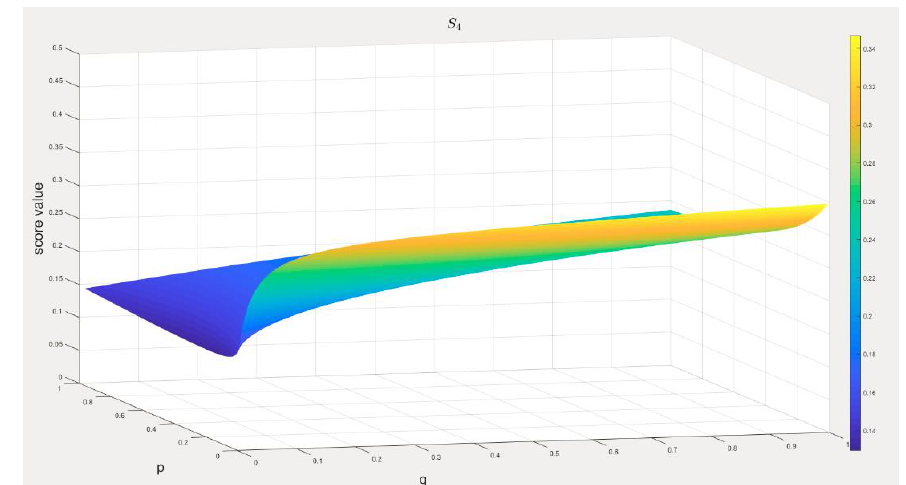
Figure 4. Values of S 3 with p , q ∈ [ 0,1 ] .